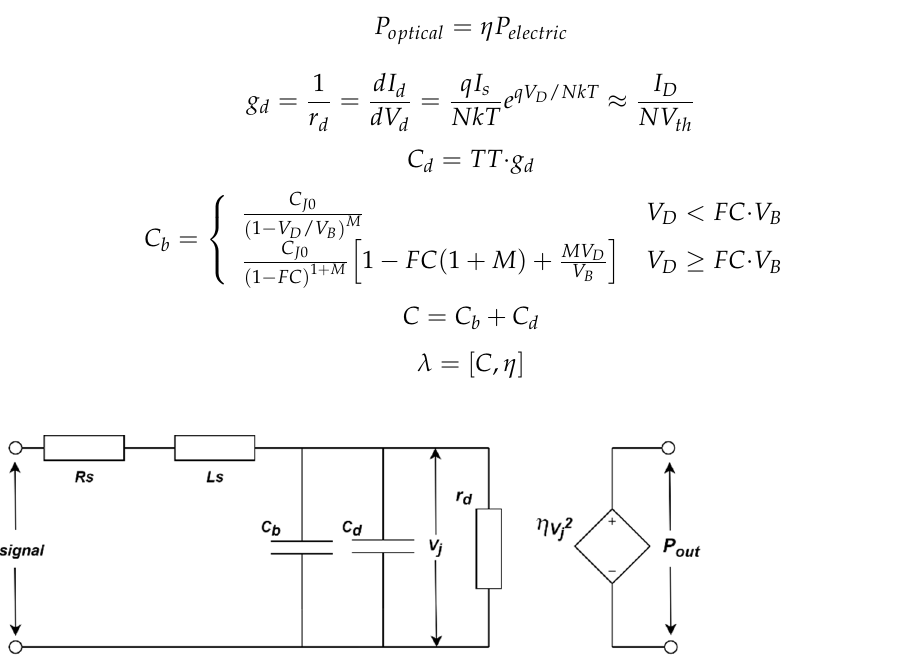
Figure 1. A Small-Signal Equivalent Circuit Model of an LED in the VLC System.